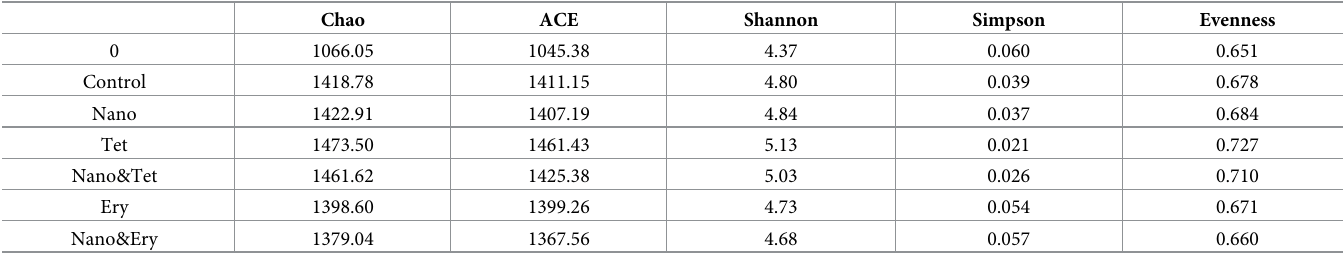
Table 2. The alpha diversity index of each experimental group.